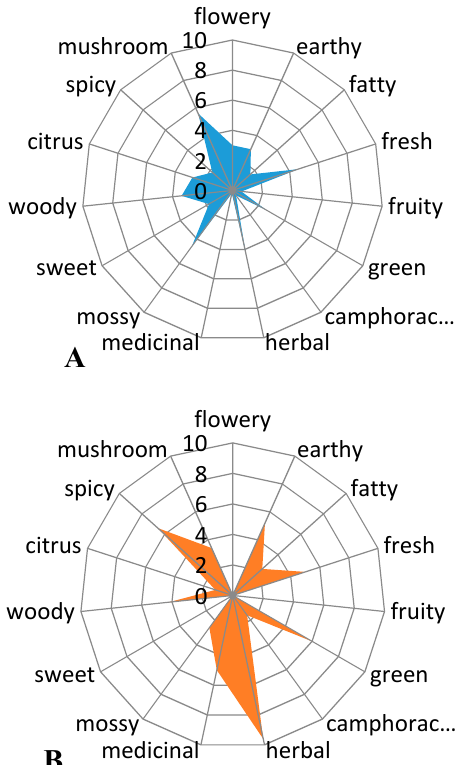
Figure 3. Aroma profile of essential oil from sonicated celery seeds assessed by men ( A ) and by women ( B ) ( n = 3).